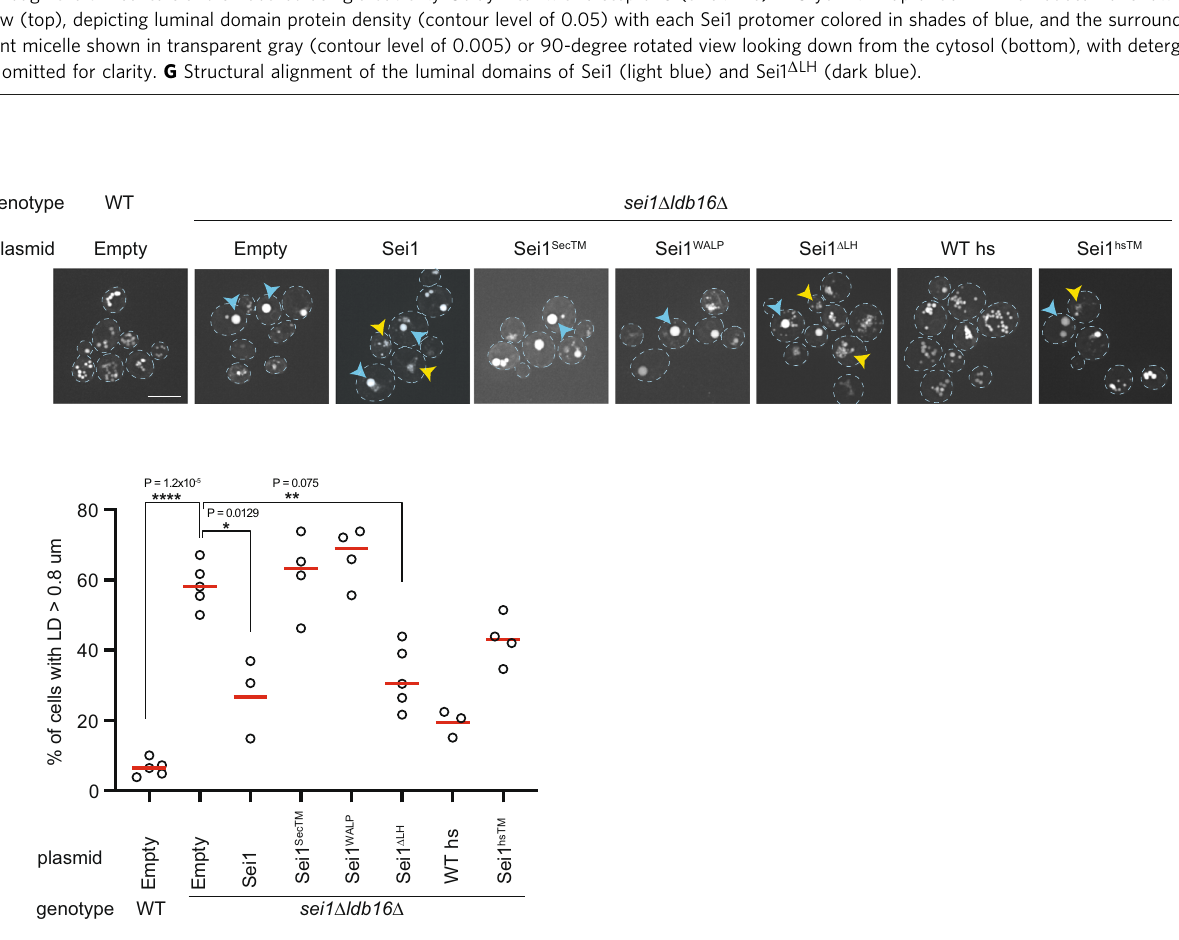
Fig. 5 Sei1 transmembrane segments contribute to LD formation. A Analysis of LDs in cells with the indicated genotype after staining with the neutral lipid dye Bodipy493/503. Scale bar corresponds to 5 µ m. Blue and yellow arrowheads indicate supersized LDs (ssLDs) and LD aggregates, respectively. B Quanti fi cation of ssLDs in cells with the indicated genotype. At least 50 cells were analysed per strain for a minimum of 3 biological replicates (WT empty vector, n = 5; sei1 Δ ldb16 Δ empty vector and Sei1 Δ LH , n = 5; sei1 Δ ldb16 Δ Sei1 SecTM Sei1 WALP and Sei1 hsTM , n = 4; sei1 Δ ldb16 Δ Sei1 and WThs, n = 3). Red bars represent median percentage. Difference in frequency of ssLDs was tested using a two sided paired t-test (* p < 0.05, ** p < 0.01, **** p < 0.0001, n.s . non-signi fi